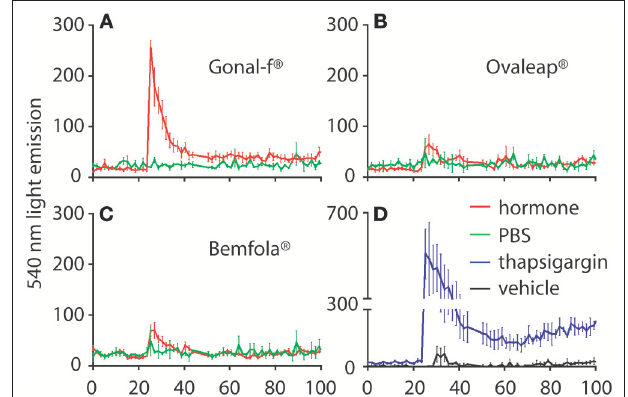
FIGURE 5 | Calcium response kinetics in transfected HEK293 cells treated with Gonal-f ® or biosimilars. Cells were transiently co-transfected with FSHR and aequorin sensors, then stimulated in duplicates with a fixed dose (4 × 10 3 ng/ml) of (A) Gonal-f ® , (B) Ovaleap ® , (C) Bemfola ® . (D) Thapsigargin, PBS and hormone diluent were used as positive and negative controls, respectively. BRET signal was measured for 100s. Data are represented as means ± SEM ( n = 3). Area under the curve (AUC) values were calculated and differences were considered for p < 0.05 (Kruskal Wallis